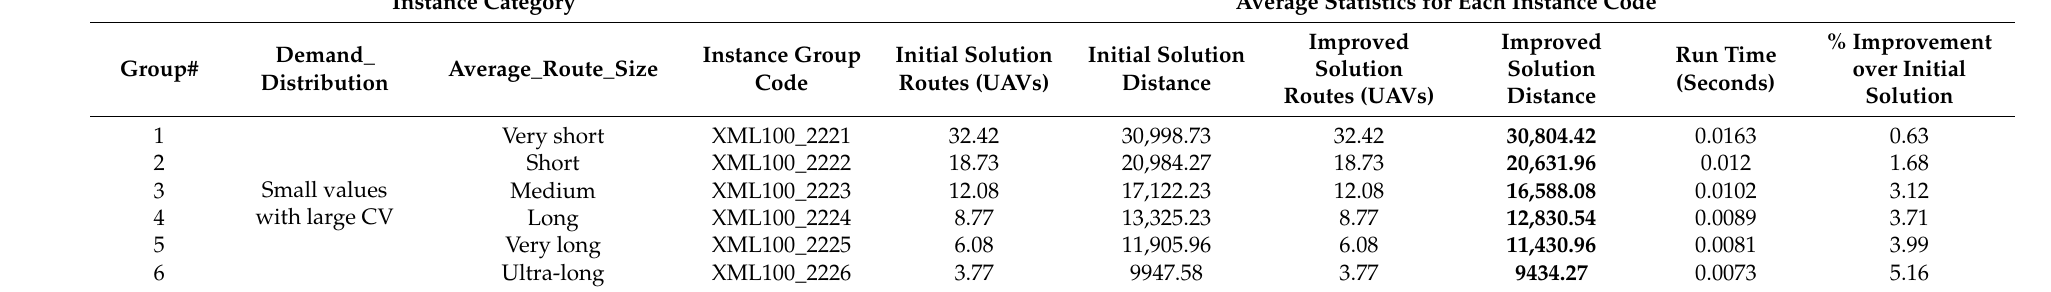
Table A2. Results of the GBCDH on the XML100 dataset with centered depots and clustered customer positioning. The bold font indicates values that offer improvements from the initial solution distance to the final solution